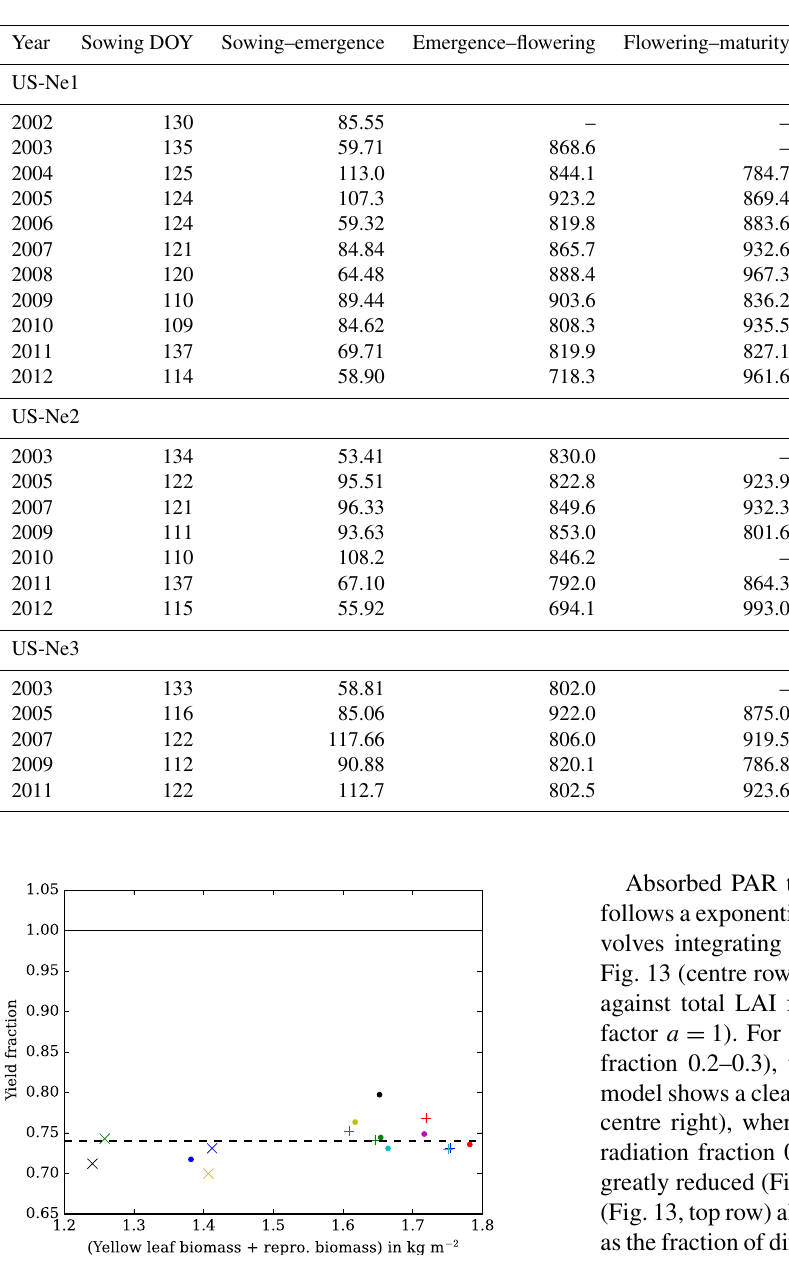
Table 5. Thermal times in degree days based on crop dates recorded at the Mead FLUXNET sites, combined with hourly observed tempera- tures.